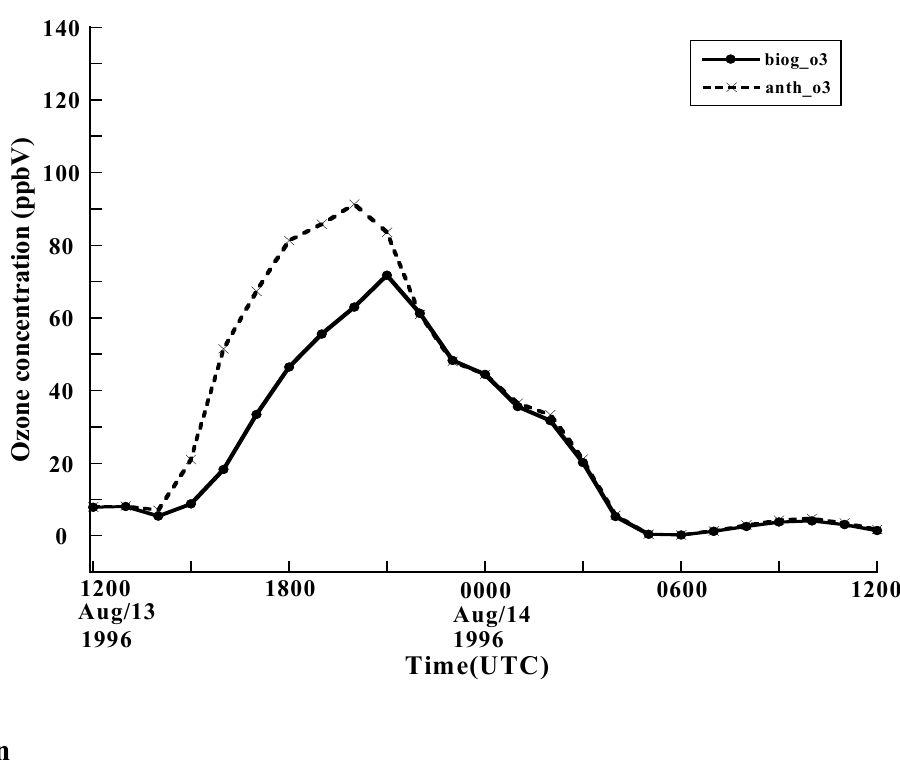
Figure 8. Surface ozone concentration comparison between the output from CMAQ running only with biogenic VOCs (solid line) and only with anthropogeinc VOCs (dashed line) at the station in downtown El